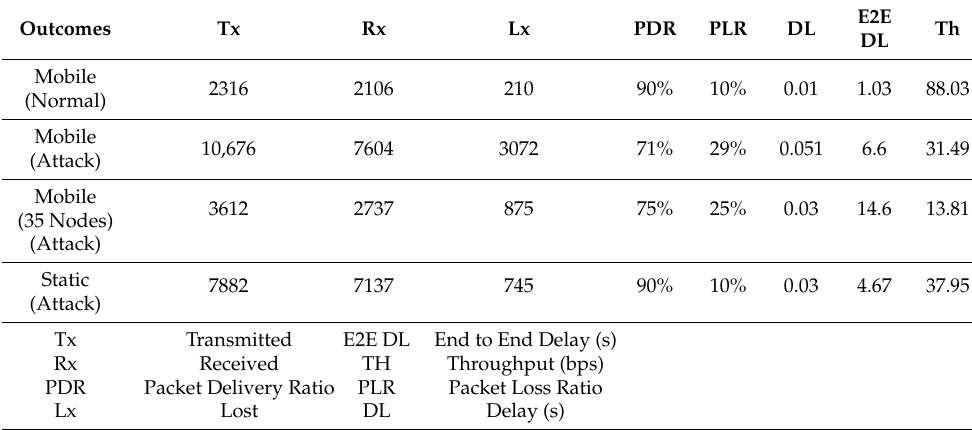
Table 4. Comparative Analysis of WSN (ad hoc).